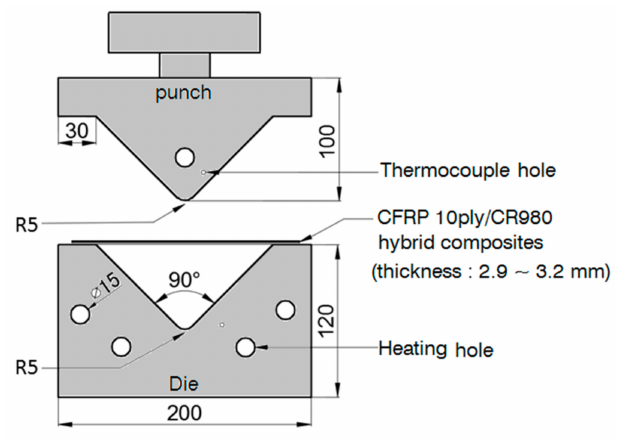
Figure 5. Drawing of mold for V-bending test of CFRP/CR980 hybrid composites (unit: